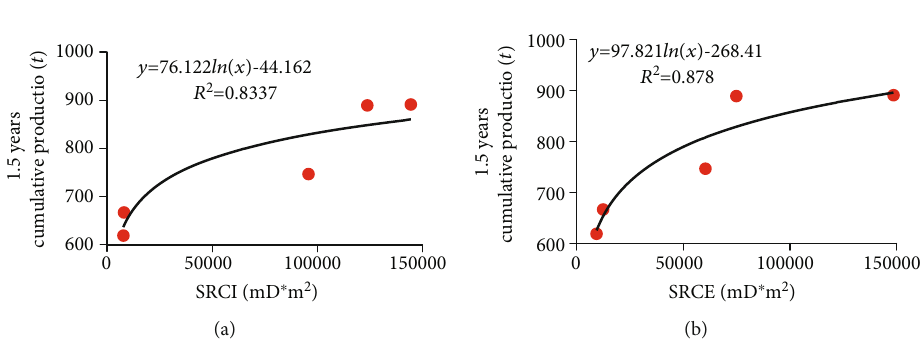
Figure 6: Decrease curve of SRC with time.